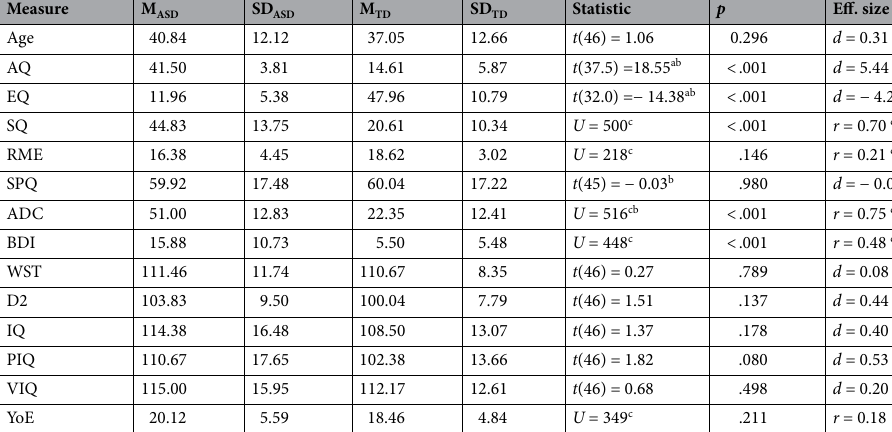
Table 1. Sample characteristics and group comparisons. Means ( M ) with standard deviations ( SD ) in the ASD group and the TD group with results of two-sided Student’s t tests ( α = 0.05) and Cohen’s d as effect sizes. Autism quotient (AQ), Empathy quotient (EQ), Systemizing quotient (SQ), Reading the mind in the eyes test (RME), Sensory perception quotient (SPQ), Adult dyspraxia checklist (ADC), Beck’s depression inventory (BDI), Wortschatztest, (WST) Concentration ability test (D2), Intelligence quotient (IQ), Performance-based intelligence quotient (PIQ), Verbal intelligence quotient (VIQ), Years of education (YoE). a Bartlett test revealed heterogeneous variances and results of Welch’s two-sample t test are reported. b